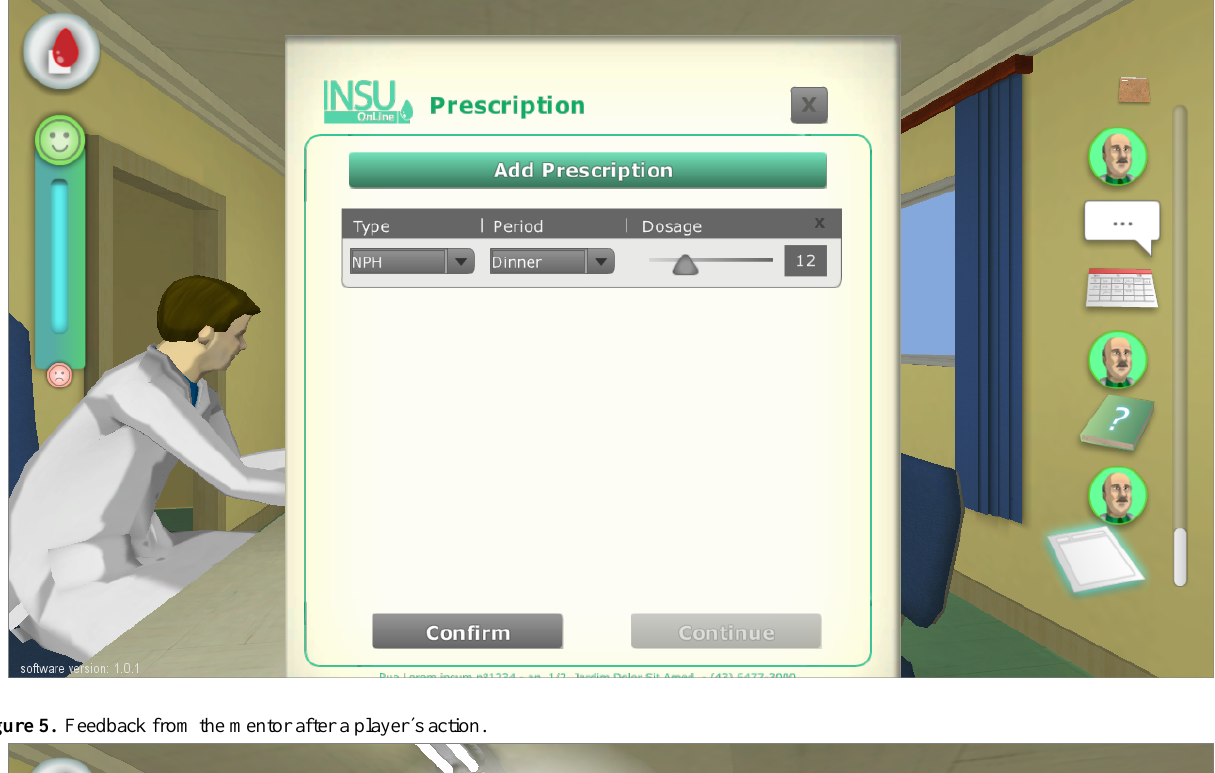
Figure 4. Panel for insulin prescription.